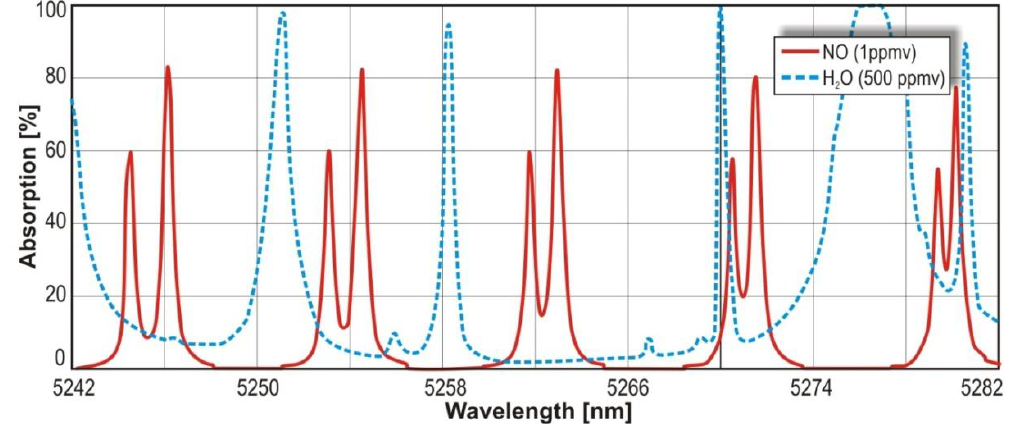
Figure 5. NO absorption spectrum.